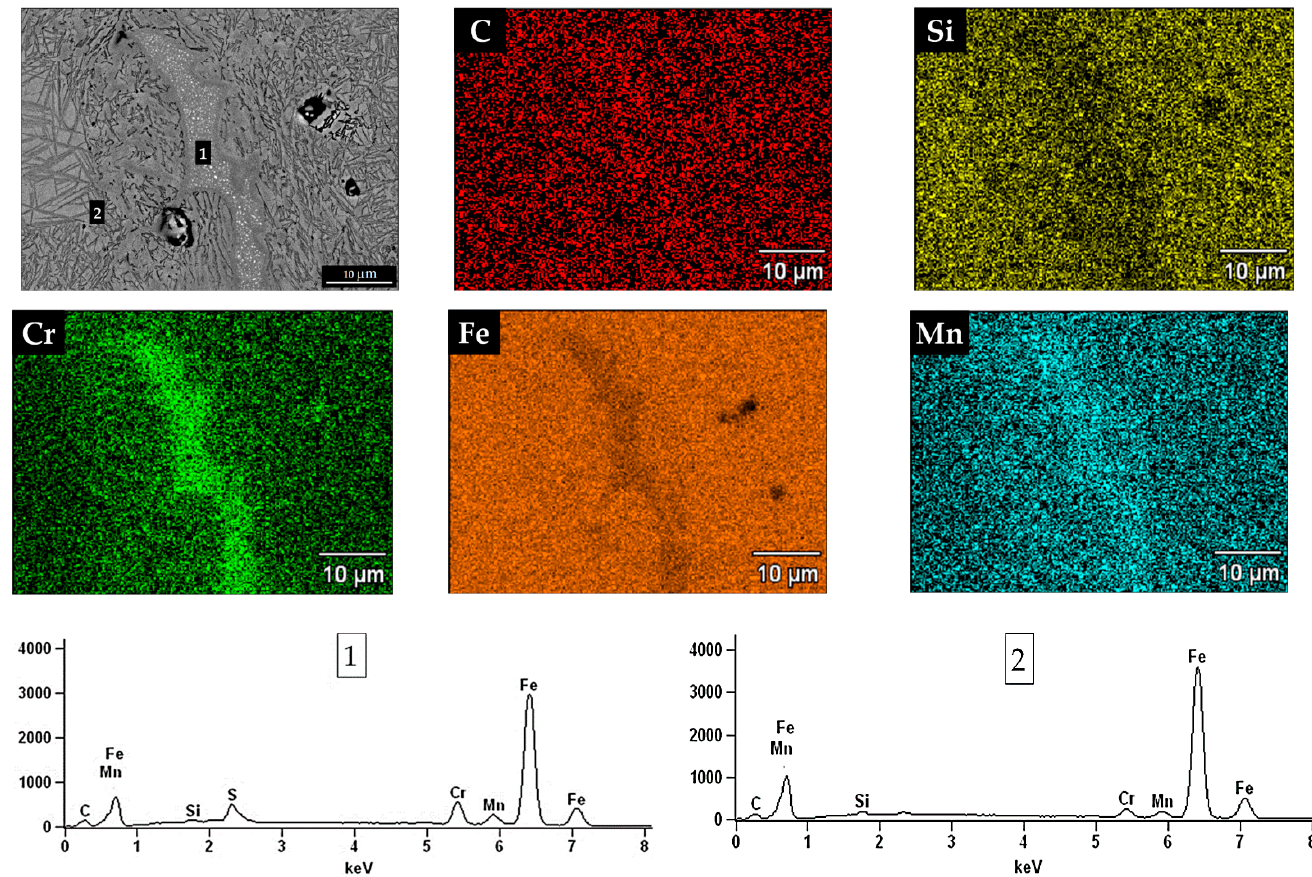
Figure 9. Carbide image by SEM-EDS and X-ray mapping of carbon, silicon, chromium, iron, and manganese of the CADI alloyed with 0.4 wt% Cr heat-treated to 265 °C for 90 min.